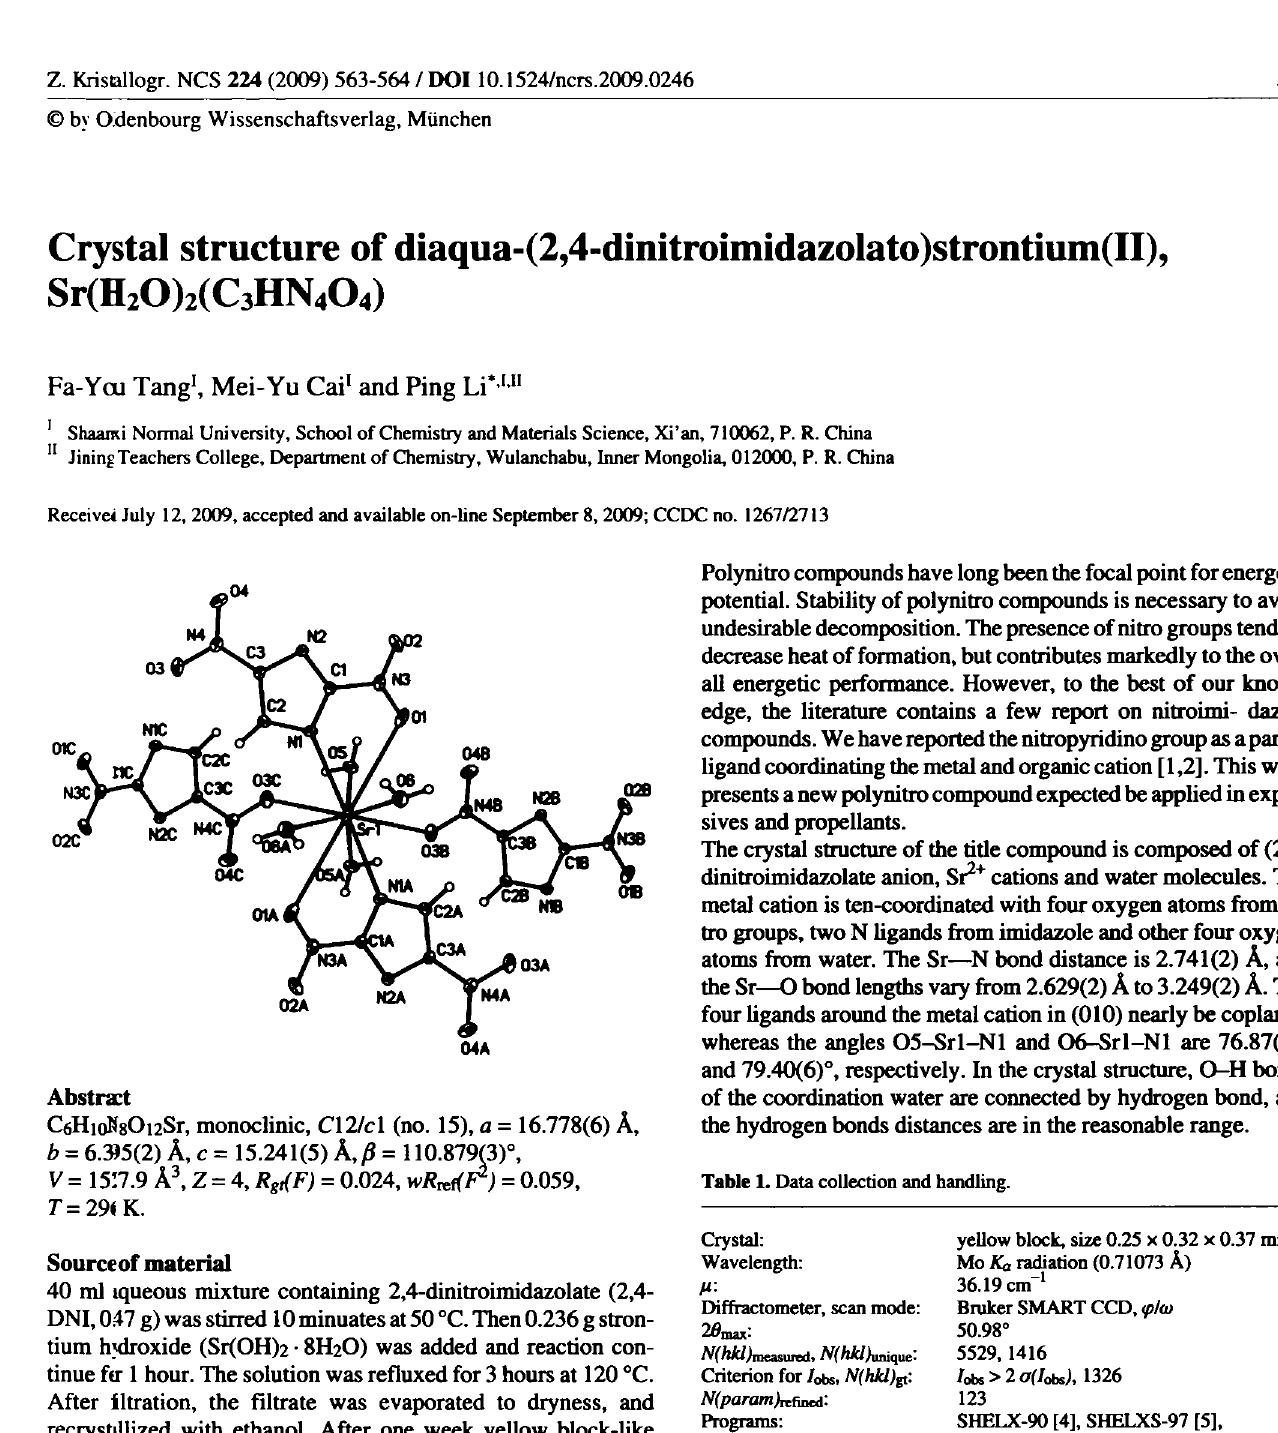
Table 2. Atomic coordinates and displacement parameters (in Â 2